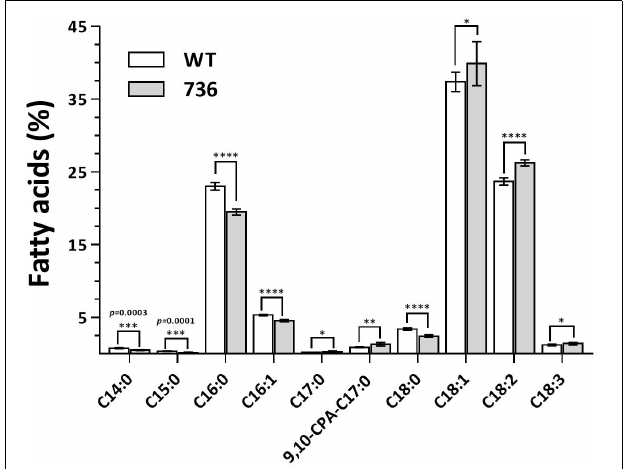
FIGURE 3 | Fatty-acid composition of the wild-type and mutant 736. Fatty acids of the wild-type (blank) and mutant 736 (gray) were extracted and analyzed with GC-MS. Statistical analysis was performed using one-way ANOVA ( ∗ p < 0.05, ∗∗ p < 0.01, ∗∗∗ p < 0.001, ∗∗∗∗ p < 0.0001, n = 10). Data are presented as mean ±